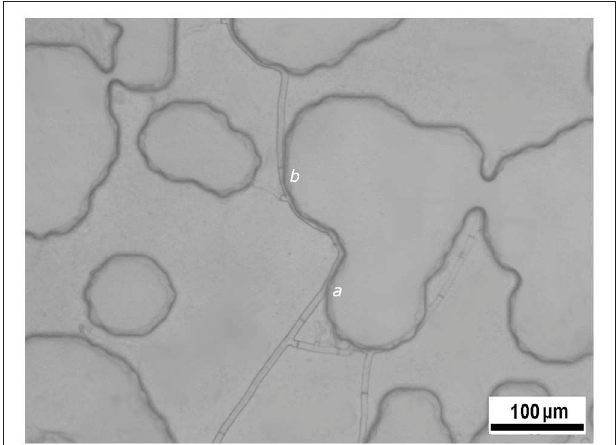
FIGURE 5 | Illustration of the tendency of hyphae to stay in close contact with pore walls once they encounter them (at point a). Nevertheless, this thigmotrophic process does not extend indefinitely, as the hypha eventually dissociates from the surface (at point